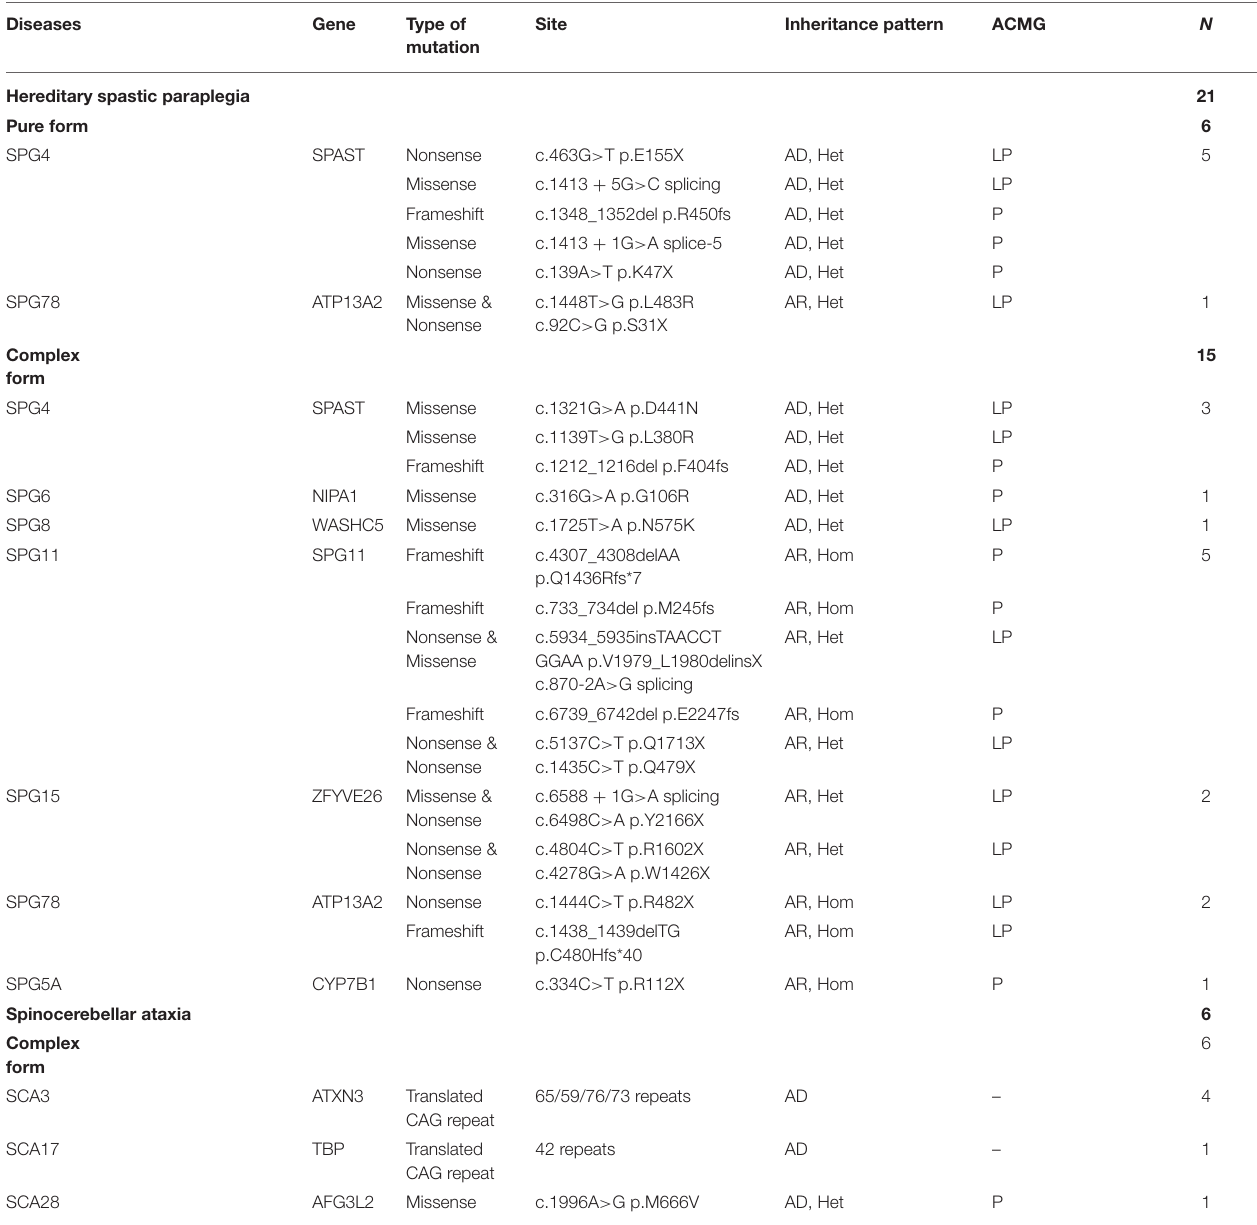
TABLE 1 | Genetic causes of the solved cases with clinically suspected hereditary spastic paraplegia.